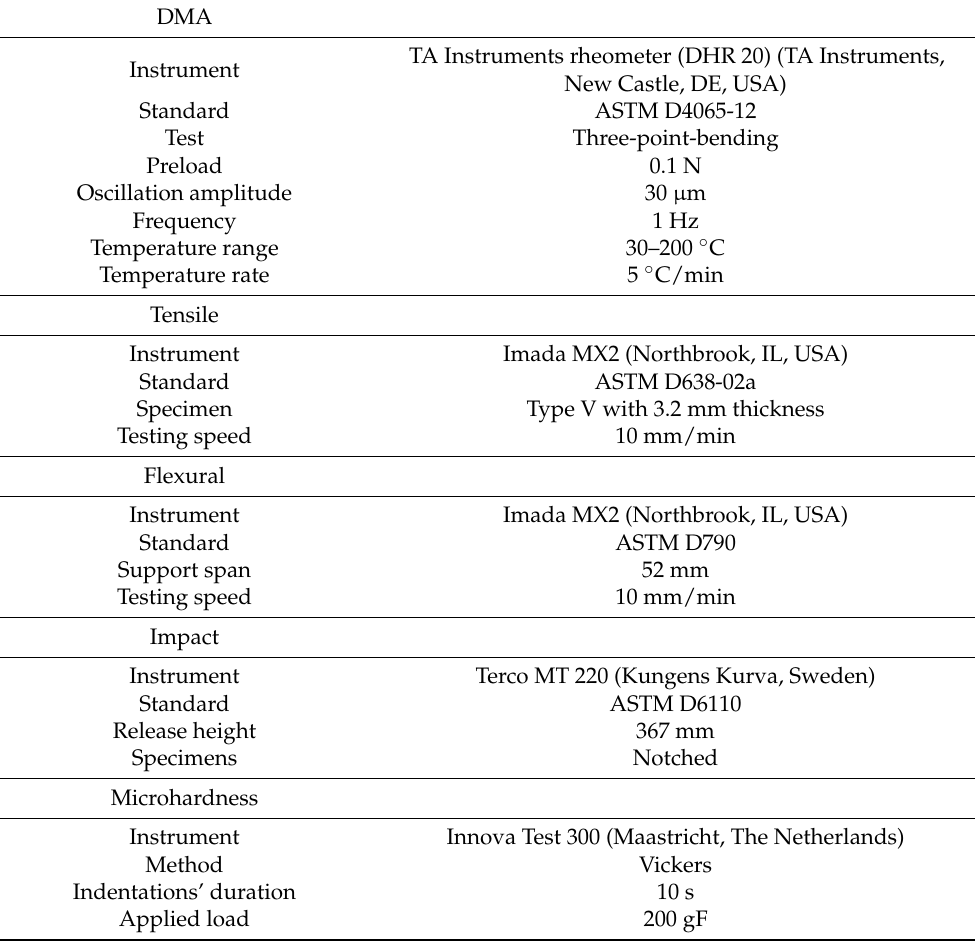
Table 2. Tests that were conducted in the work for the mechanical characterization of the prepared